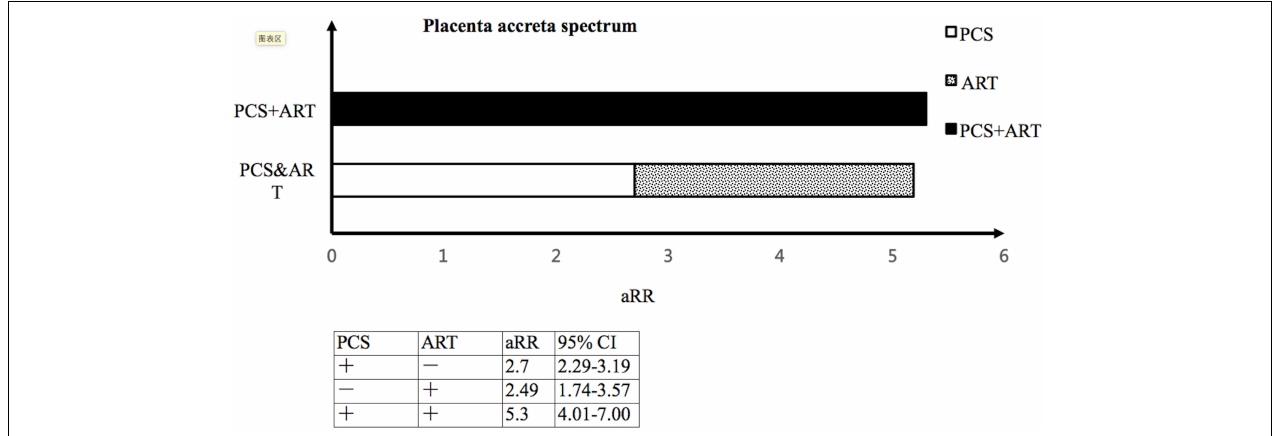
FIGURE 2 | The interaction between the implementation of ART and previous CS on the risk of placenta accreta spectrum. ART, assisted reproductive technology; CS, Cesarean section; aRR, adjusted risk ratio; CI, confidence interval.